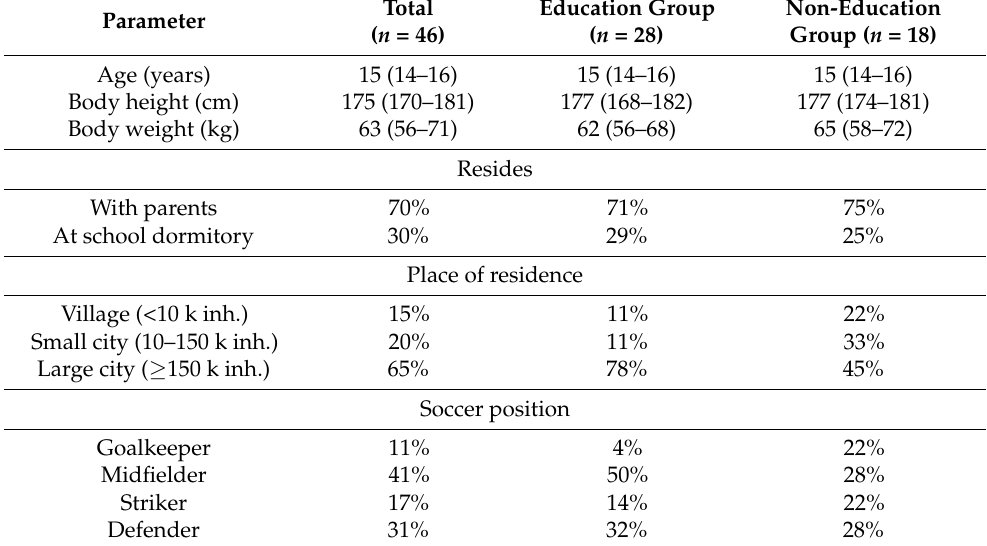
Table 1. Baseline characteristic of the study cohort.